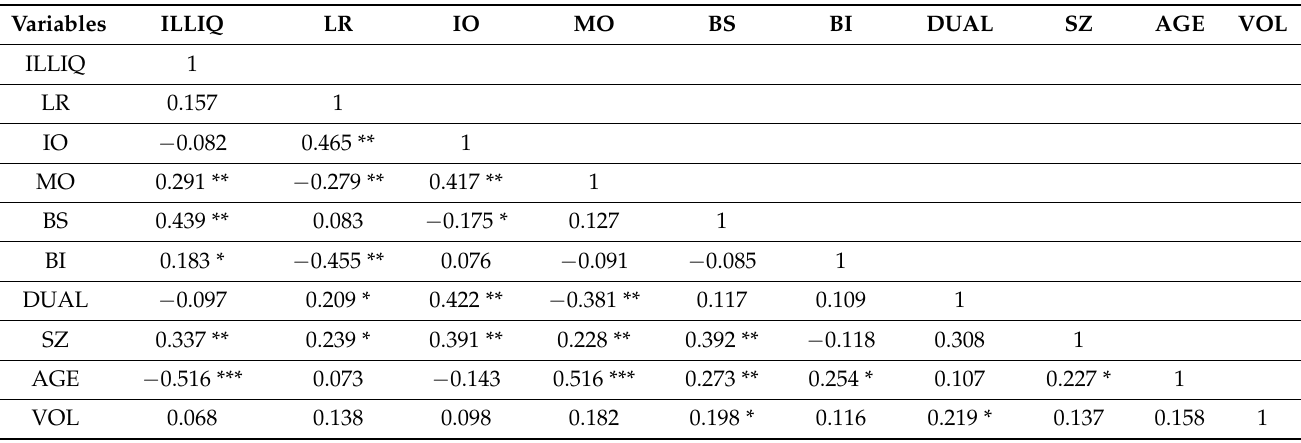
Table 3. Correlation analysis.